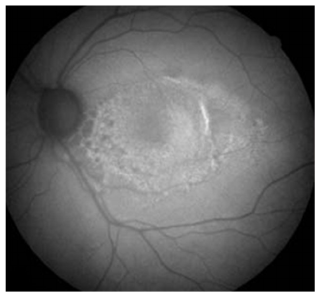
Figure 3. Fundus autofluorescence image from a degenerated macula indicating increased lipofuscin accumulation with increased autofluorescence signal.